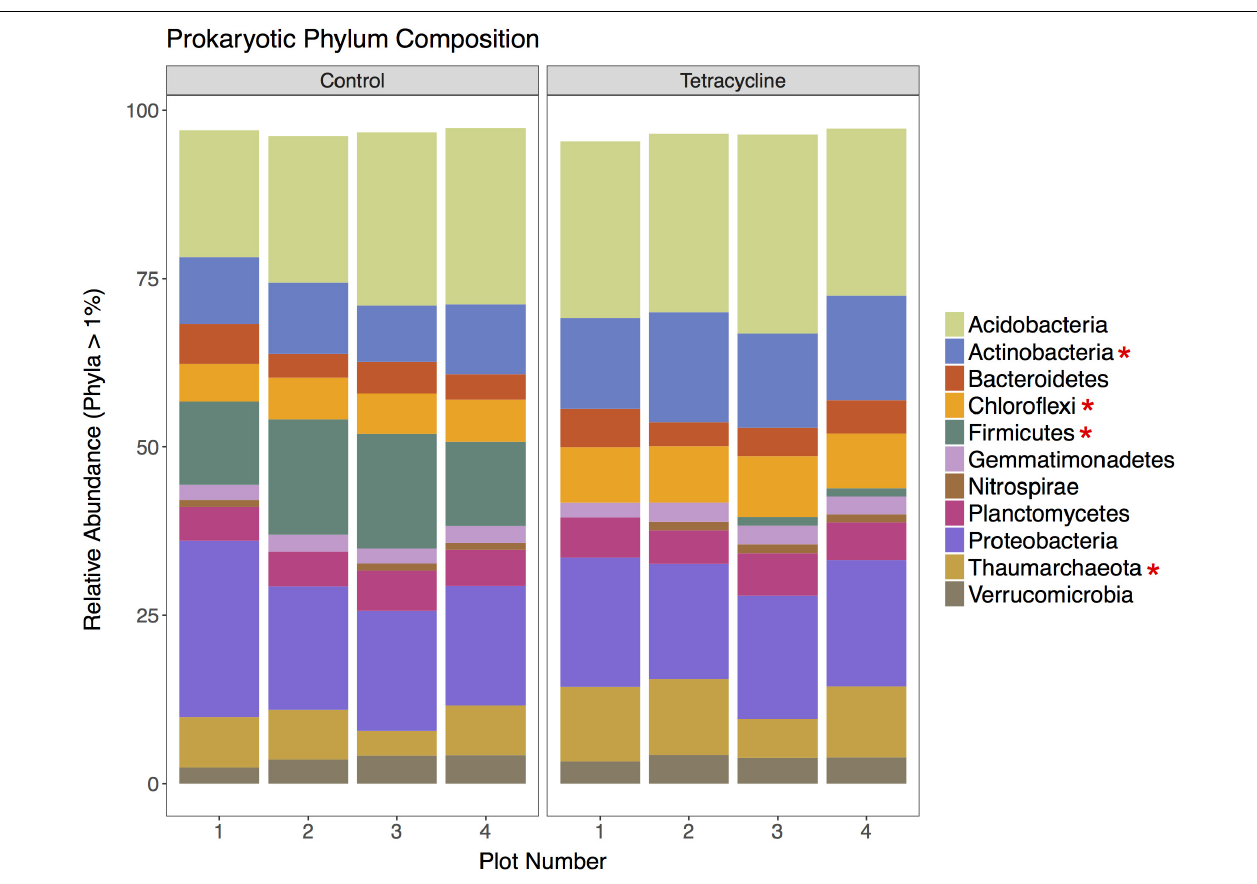
FIGURE 3 | Prokaryotic community composition at the phylum level for control and tetracycline samples. Only phyla with relative abundance higher than 1% are shown. Phyla with significant difference between control and tetracycline samples are marked with ∗ in the legend (paired t -test, p < 0.05).